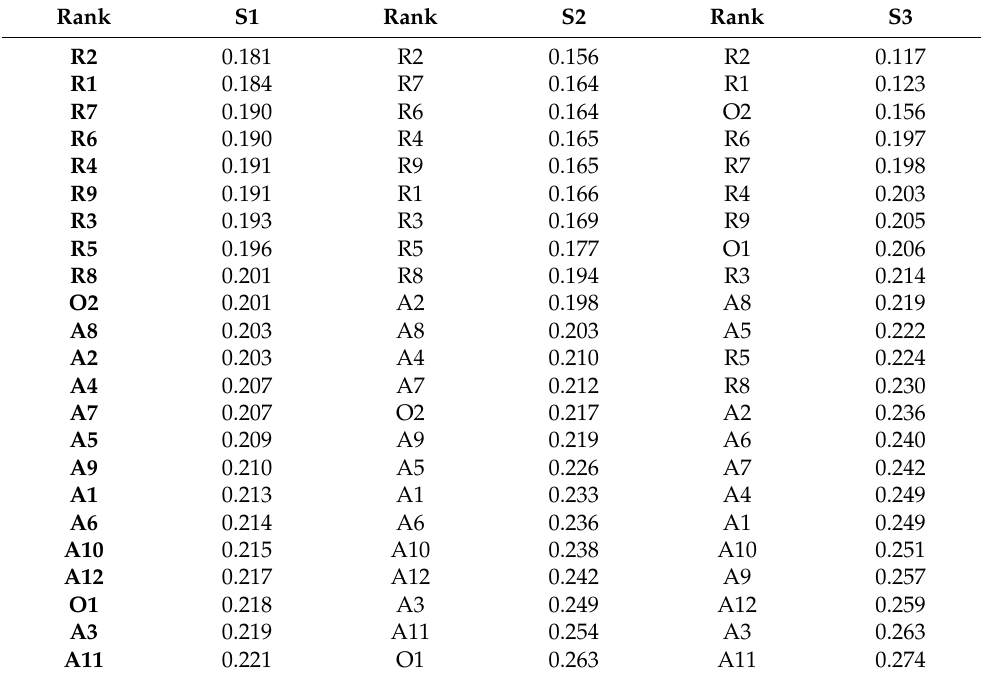
Table 7. The three scenario